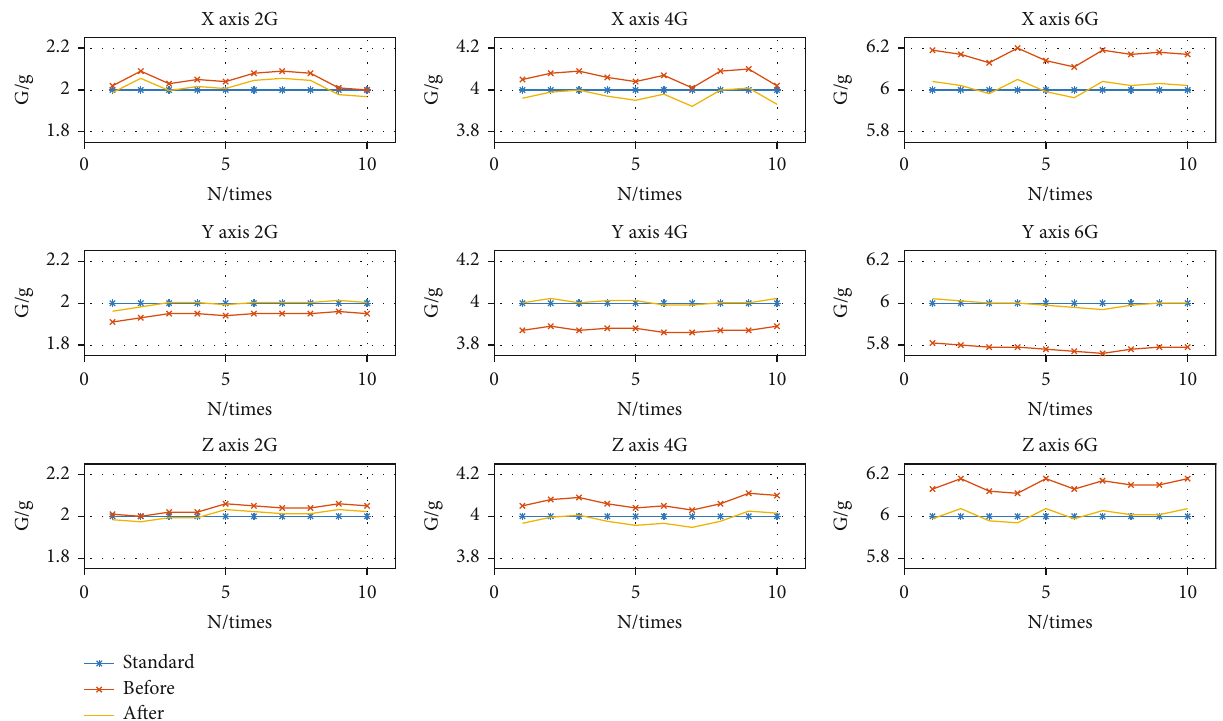
Figure 10: Comparison of measured and standard values of triaxial acceleration before and after linear coe ffi cient compensation (blue: standard, red: before, and orange: after).